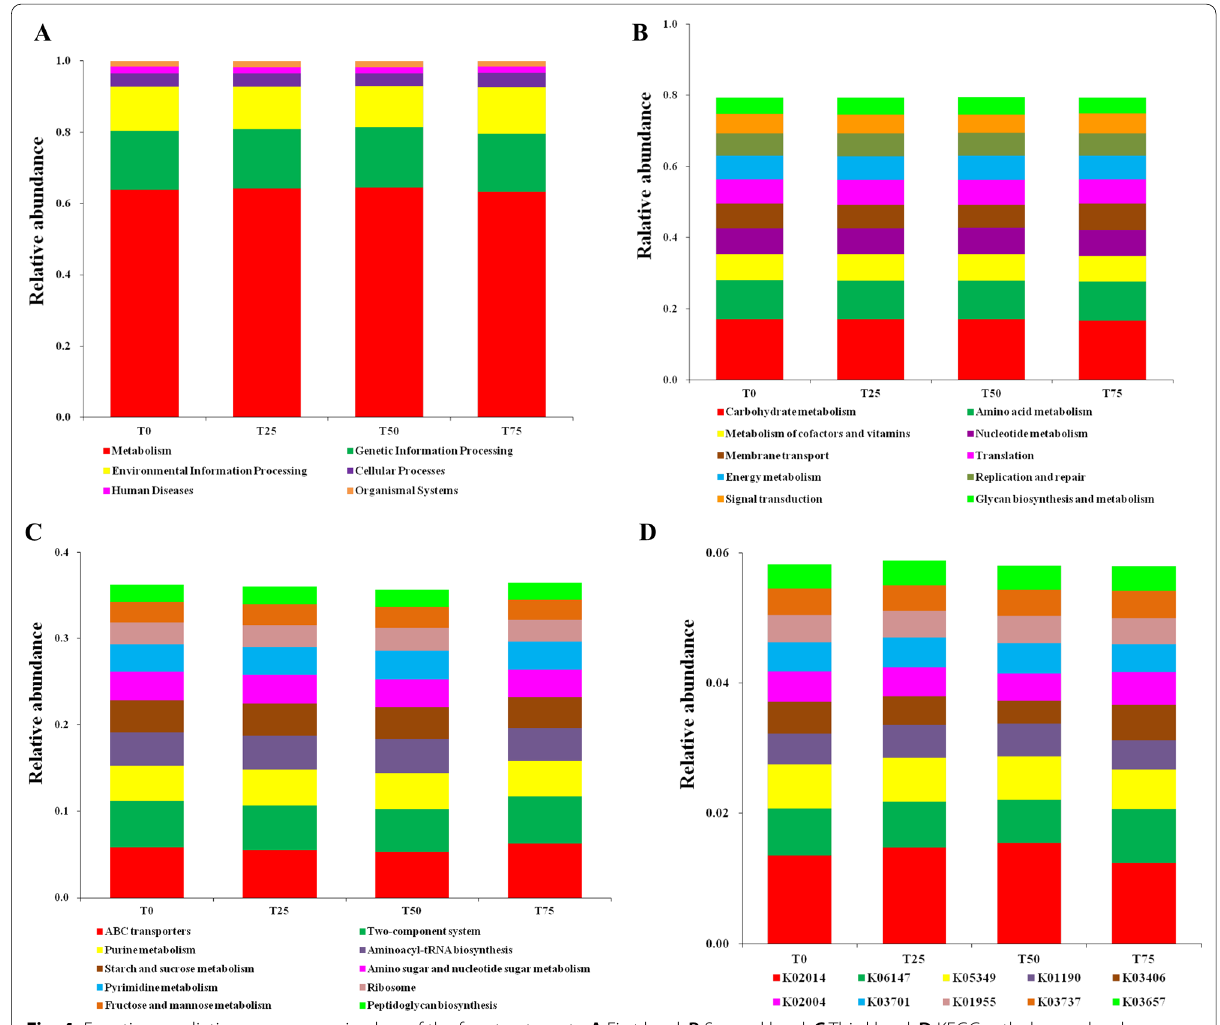
Fig. 4 Function prediction on rumen microbes of the four treatments. A First level; B Second level; C Third level; D KEGG orthologues